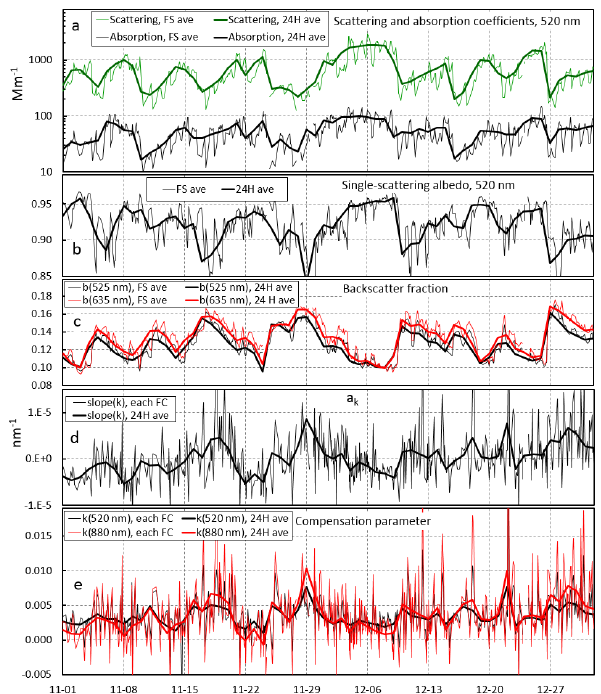
Figure 3. Selected optical properties in November–December 2013. (a) Scattering and absorption coefficients at λ = 520nm, (b) single-scattering albedo at λ = 520nm, (c) backscatter fraction at λ = 525nm and λ = 635nm, (d) the slope ( a k ) of the wavelength dependency of the compensation parameter, and (e) the compensa- tion parameter ( k ) at λ = 520nm and at λ = 880nm. In (a–c) the thin lines show the filter-spot-averaged (FS ave) values, in (d–e) the individual slopes and compensation parameters at each filter change (FC). The thick lines show the 24h-averaged values in all figures.